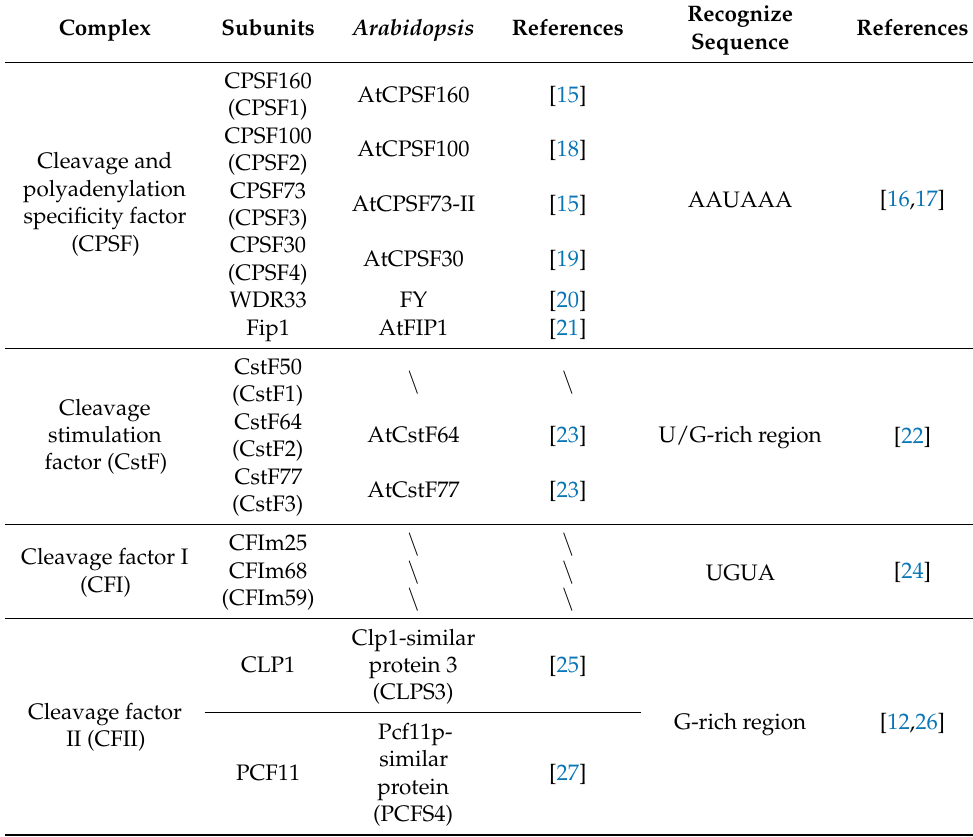
Table 1. Homologues of core cleavage and polyadenylation factors in plants. Complex Subunits